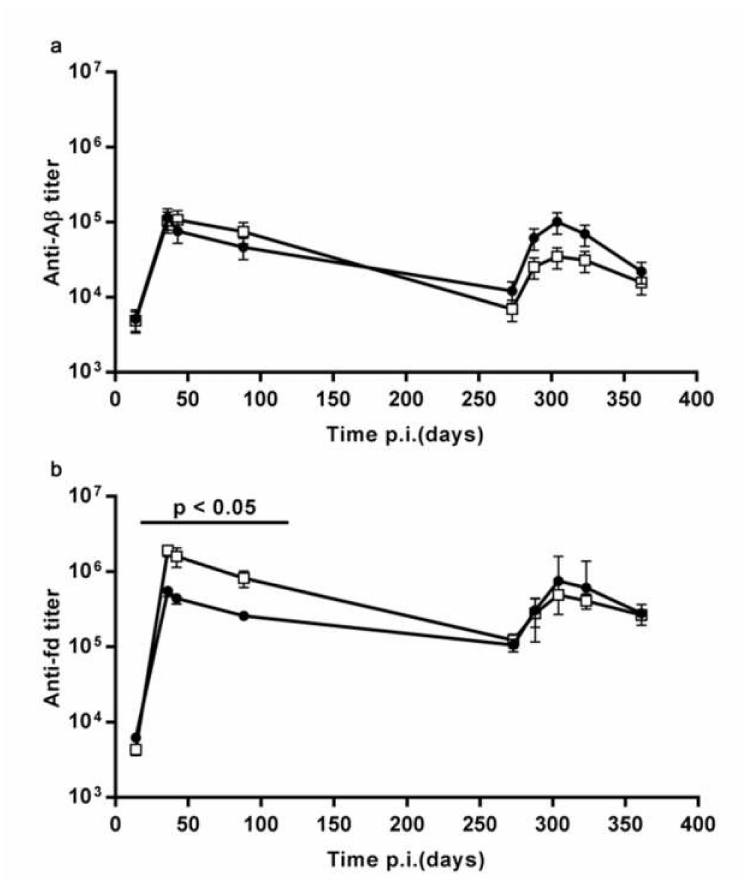
Figure 4. The graphs report the time course of the IgG titer against A β ( a ) and fd ( b ), GMT ± SEM, of the SD group (full circles) overlayed to the D15B group (open squares). In both groups n = 10. The primary IgG response against A β and fd is not reduced by a day 15 booster